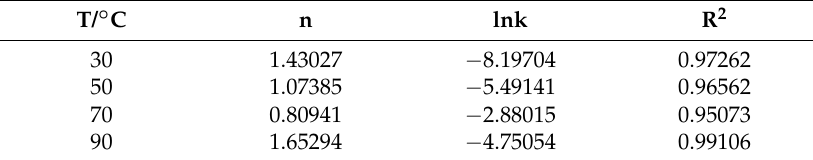
Figure 9. Plots of ln( − ln(1 − x)) vs. lnt at different leaching temperatures. Table 3. Kinetic parameters during the Pt leaching process using the Avrami model.